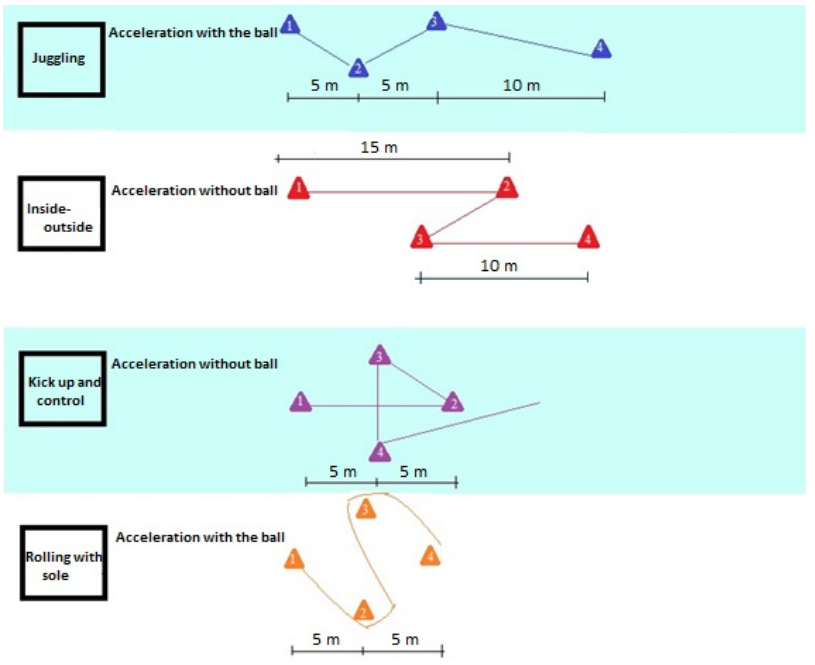
Figure 1. Ball control and acceleration routine. Notes: (1–4) Sequence of the exercises. During session “B”, they completed plyometric activities and vertical jumps over 20– 40 cm high household obstacles. At the end of each repetition, they executed 2–3 m linear accelerations. We designed four sets of exercise routines. The first exercise routine ( a ) included ladder runs, forward-backward jumps, zig-zag runs, and acceleration with the ball. The second exercise routine ( b ) incorporated forward-leftward-rightward- rightward-leftward-forward jumps, zig-zag runs with the ball, and acceleration with the ball. The third exercise routine ( c ) included repeated forward jumps (four times), zig-zag runs with the ball, and acceleration. The fourth exercise routine ( d ) contained lateral hops (four times) and acceleration with the ball and around the cone (Figure 2). Participants executed each exercise for 10–15 s at maximum intensity (90–100%), repeated six times. We provided 45–50 s of rest between each repetition. Between sets, there was 4 min of passive rest. After the training session, we provided 72 h of rest for the athletes.